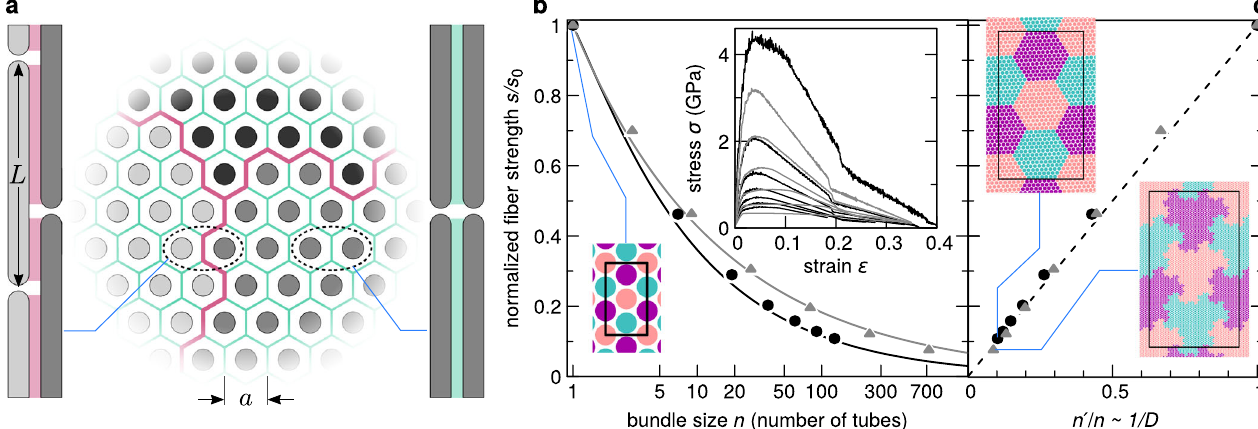
Fig. 1 Morphology and tensile behavior of a bulk fi ber element. a Schematic representation of the domains or bundles (different shades of gray) viewed axially, demarcated by thicker lines which also represent the inter-domain interfaces. The thinner lines represent intra-domain interfaces. Each interface is represented by the edge of a tube ’ s (hexagonal) Wigner--Seitz cell with length a = distance. The side cartoons show the axial arrangements of the encircled tubes: (left) inter-domain and (right) intra-domain interface. b Computed tensile strength of a representative fi ber volume element as a function of the number of tubes (bundle size) in a constitutive domain for two domain shapes, shown in ( b ): hexagonal (circles) and fractal (triangles). The top-inset shows the respective stress-strain curves used to obtain s for each domain shape. The solid lines are the analytical fi ts s ( n ) to the computed data points for the corresponding domain shapes (see Supplementary Note 2). Bottom-inset shows the unit cell for the domain-less ( n = 1) fi ber. c The same data points as in b , but plotted as a function of the periphery-to-bulk ratio n 0 = n (cid:1) 1 = D ; the dashed line corresponds to s = s 0 ¼ n 0 = n . Insets show cross-sectional views of the hexagonal and fractal systems, for their largest simulated bundle sizes: n = 61 and 729, respectively. The black rectangles denote the boundaries of the periodic cell. Tubes in the same domain/bundle are shown in the same